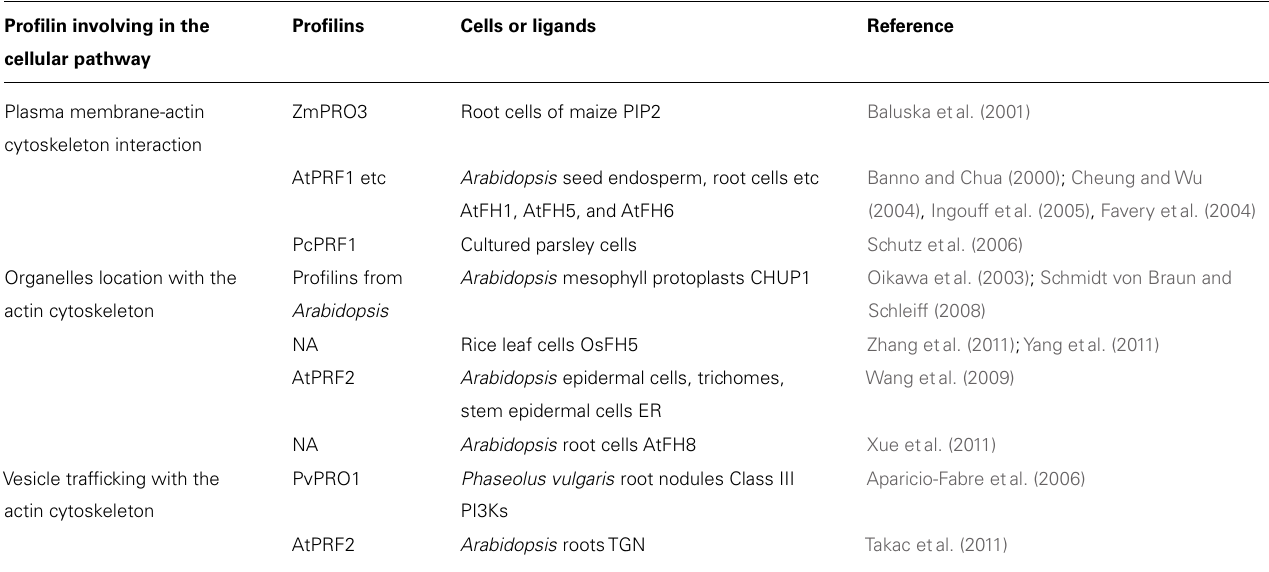
Table 1 | Profilin and its cellular functions in plant